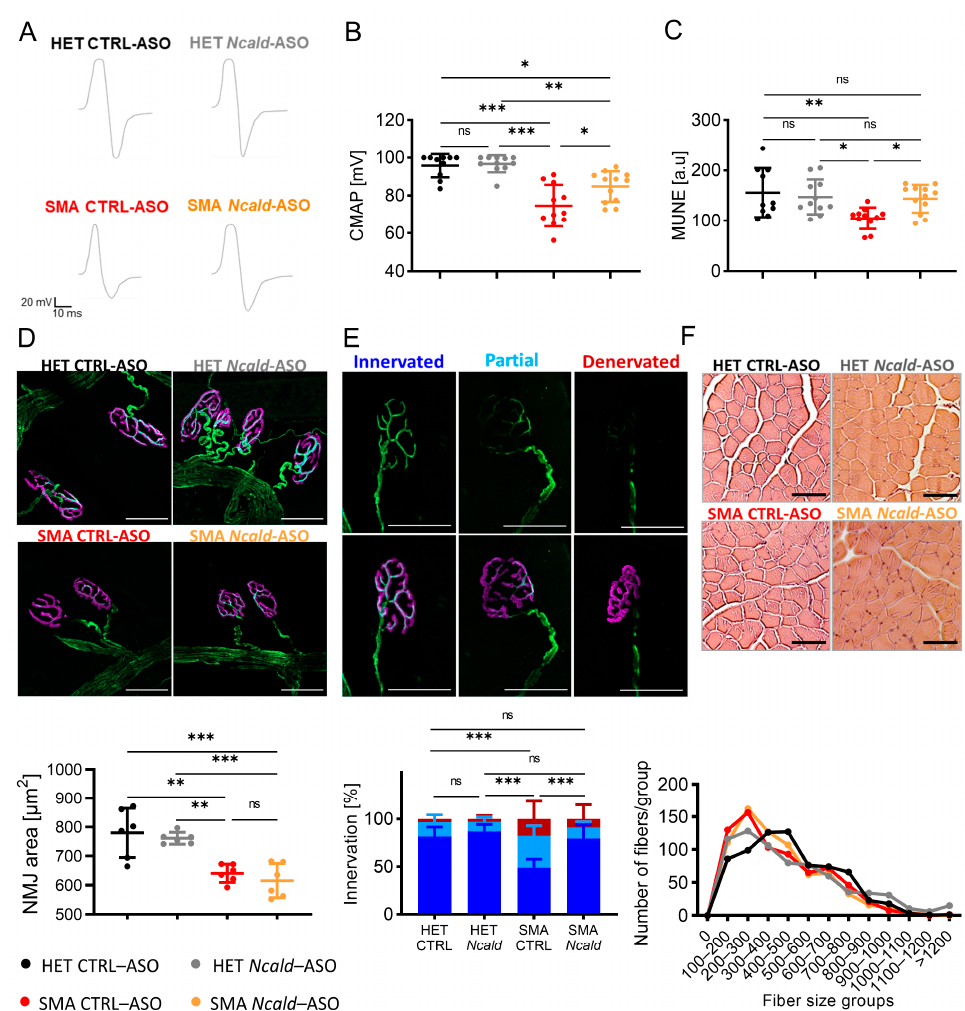
Figure 2. Re-injection with 500 µg Ncald –ASO improves electrophysiological defects and NMJ innervation at 2 months. ( A ) Representative traces of CMAP response in HET and SMA mice in the gastrocnemius muscle at 2 months of age, 4-weeks after re-injection. ( B ) Quantification of sciatic CMAP response of the gastrocnemius muscle in the four analyzed experimental groups. For CMAP response, peak-to-peak amplitude was quantified. Each dot in the graph represents one animal, N = 10–12. Ordinary one-way ANOVA with Tukey post hoc test for multiple comparisons. Error bars represent ± SD. * p ≤ 0.05, ** p ≤ 0.01, *** p ≤ 0.001. ( C ) Quantification of the gastrocnemius muscle MUNE in the four analyzed experimental groups. Each dot in the graph represents one animal, N = 10–12. Ordinary one-way ANOVA with Tukey post hoc test for multiple comparisons. Error bars represent ± SD. * p ≤ 0.05, ** p ≤ 0.01. ( D ) Transversus abdominis NMJ area. Representative images and quantification of NMJ area (below) at 2 months of age, showing postsynaptic NMJ region (BTX, magenta) and presynaptic nerve (NF, green) (scale bar: 50 µ m). NMJ area was analyzed with ImageJ (N = 6, n = 100 NMJs/mouse). Statistics were performed with mean values of animals per group. Ordinary one-way ANOVA with Tukey post hoc test for multiple comparisons, ** p ≤ 0.01, *** p ≤ 0.001. ( E ) Transversus abdominis NMJ innervation. Representative images of TVA NMJ innervation in each category, showing the postsynaptic region (BTX, magenta) and presynaptic nerve (NF, green). NMJ innervation was classified in three categories according to the degree of innervation. Quantification (below) of all four experimental groups. HET CTRL-ASO (N = 5, n = 272), HET Ncald -ASO (N = 5, n = 270), SMA CTRL-ASO (N = 5, n = 259), SMA Ncald -ASO (N = 6, n = 322). Results are presented